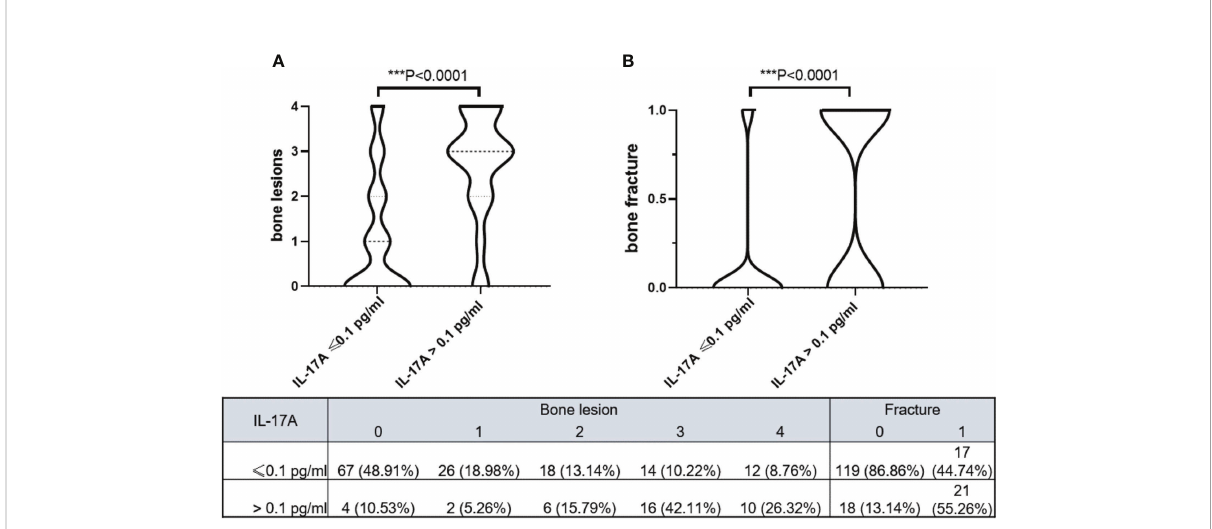
FIGURE 2 Violin plots show bone lesion levels and bone fracture in different serum IL-17A groups. (A) MM patients with serum IL-17A > 0.1 pg/ml had higher bone lesion levels (p < 0.0001). (B) MM patients with serum IL-17A > 0.1 pg/ml had more bone fracture (p < 0.0001). The model was adjusted for age, sex, hypertension history, diabetes history, immunoglobulin type, light chain type, RISS, and serum creatinine. Bone destruction in the skull, scapula, vertebrae, sternum/clavicle, ilium/pelvis/sacrum/pubis, and femur/humeral area detected by MR/CT/PET-CT scored 1 point, and the total score of the bone-damage area was recorded as bone lesion level. Wherever detected, a fracture was recorded as 1. MM, multiple myeloma; RISS, revised International Staging System. *** means